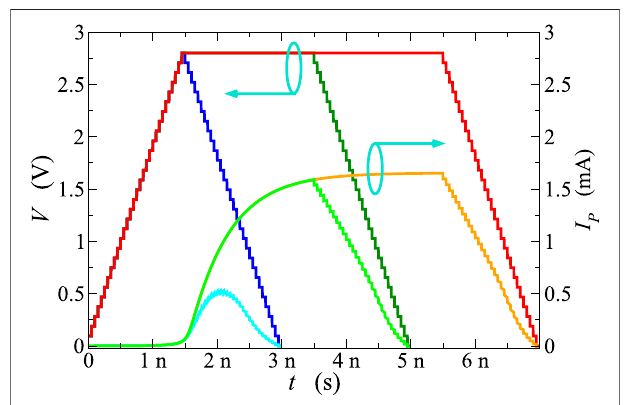
FIGURE 6 | Current fl owing across the PCM device as a function of time (right scale) after the application of voltage trapezoidal pro fi les of 2.8 V amplitude (left scale). Rise and fall times are 1.5 ns in all cases, whereas the plateau durations are 0, 2, and 4 ns.